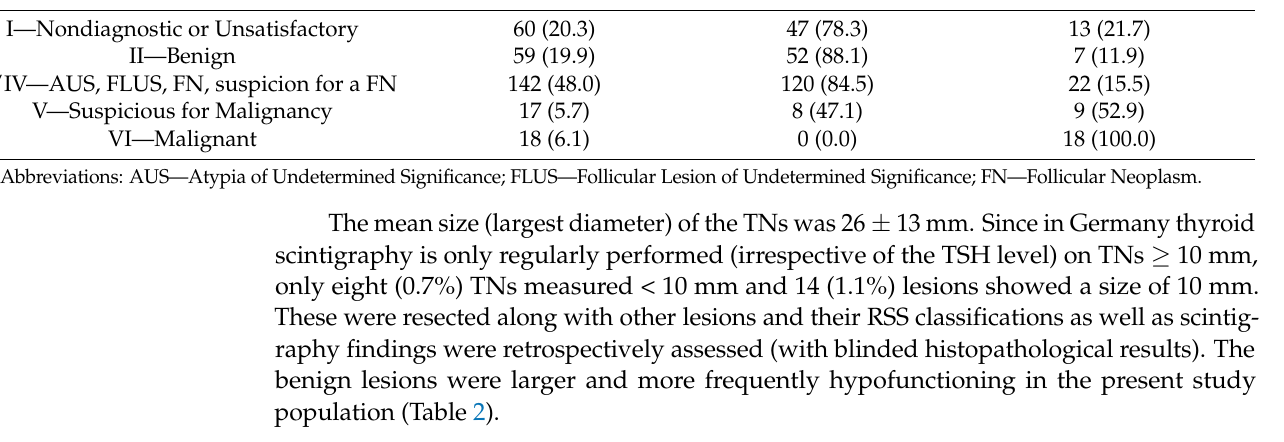
Table 2. Scintigraphy results and lesion